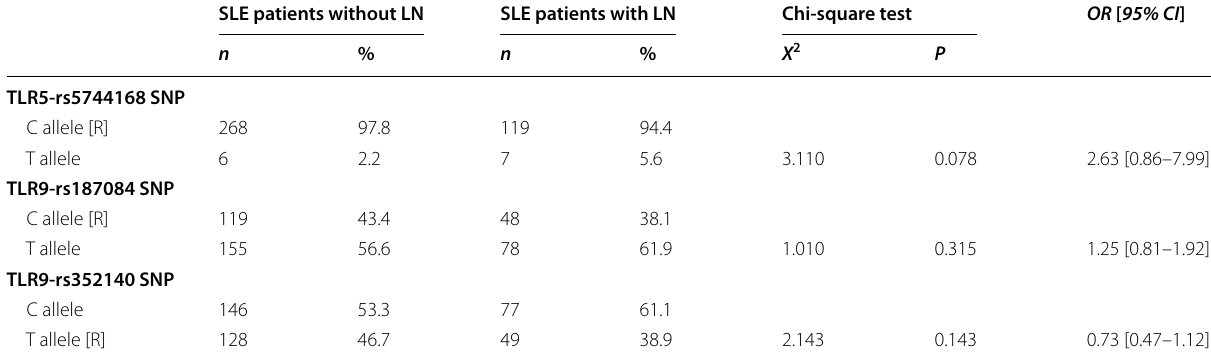
The chi-square test is used. P is set significant if